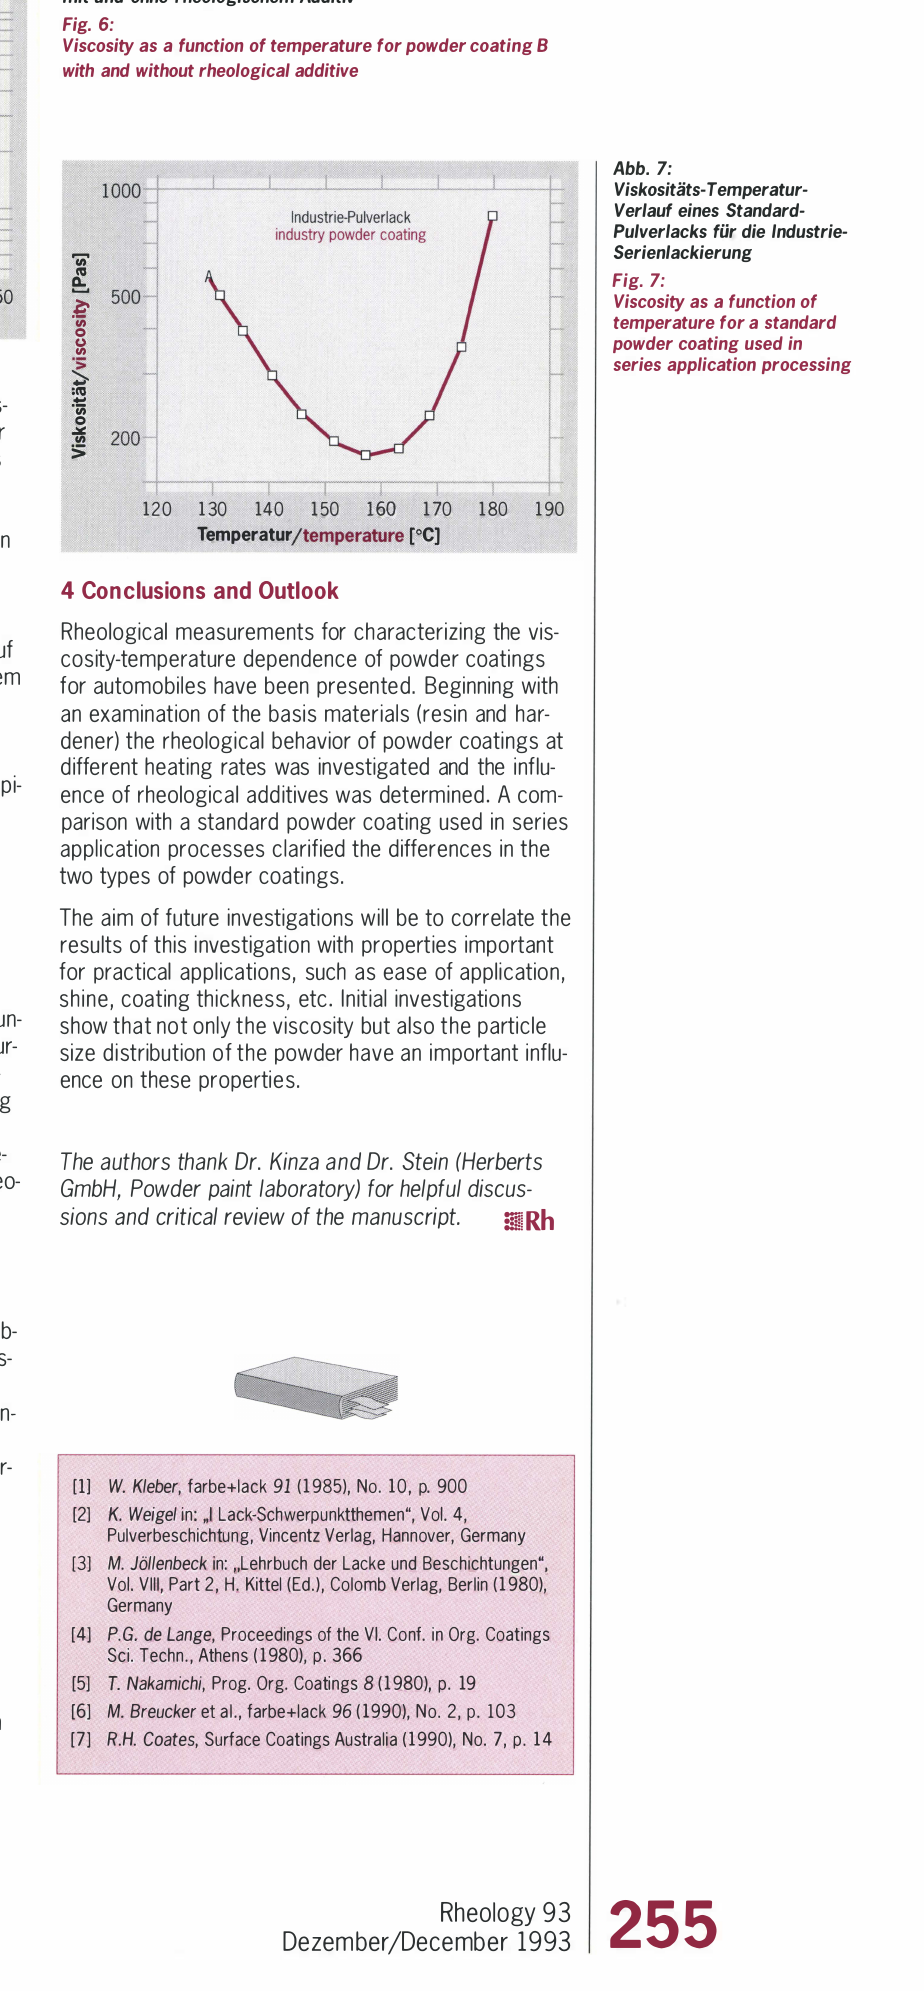
Fig. 6: Viscosity as a function of temperature for powder coating B with and without rheological additive